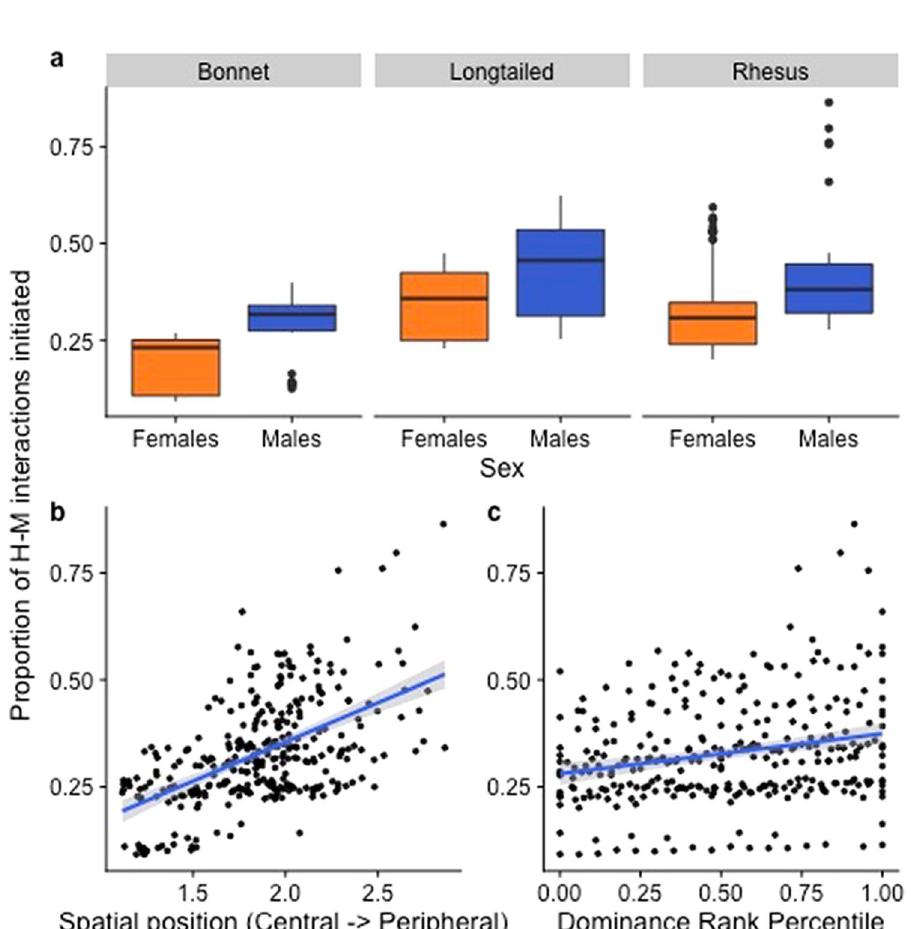
Figure 7. Effect of sex, species, spatial position, and dominance rank on the proportion of human–macaque interactions initiated by macaques. Figure was created using R (Version 3.6.1: https ://www.r-proje